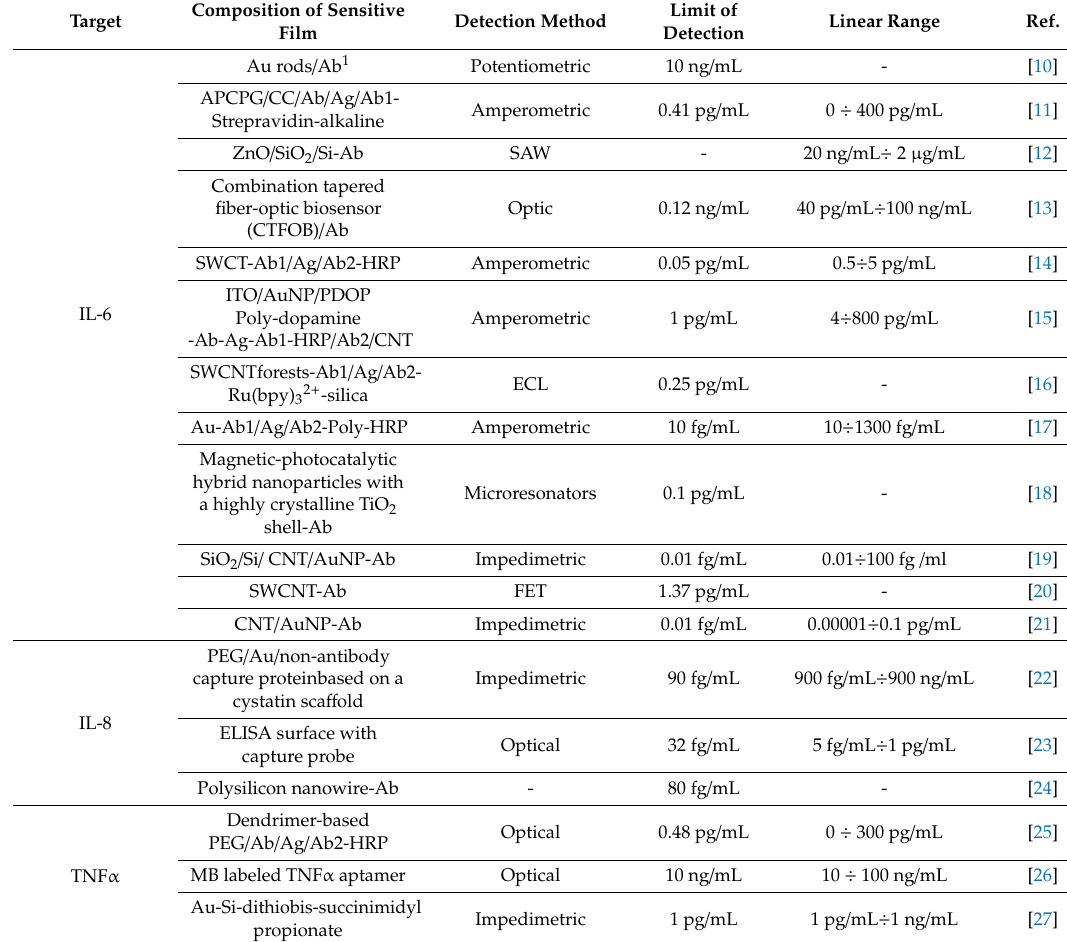
Table 3. Properties of di ff erent types of biosensor for detection of IL-6, IL-8, and TNF α .